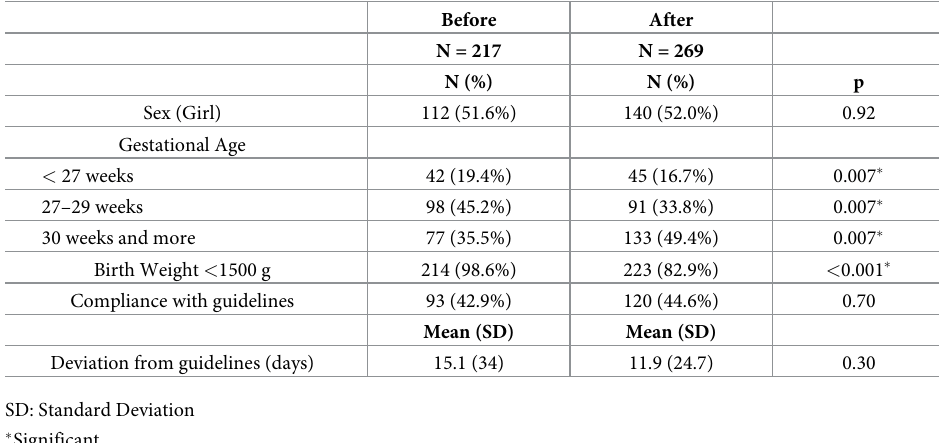
Table 3. Infants characteristics and outcomes for effectiveness—Port-Royal medical center, before and after